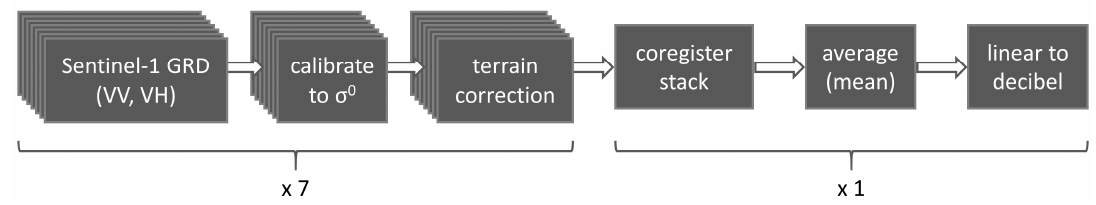
Figure 2. The intensity processing chain applied automatically to the Sentinel–1 data in the CreoDIAS cloud environment. The numbers below show how the time series of seven images are reduced to one layer for each area in which the model is applied.